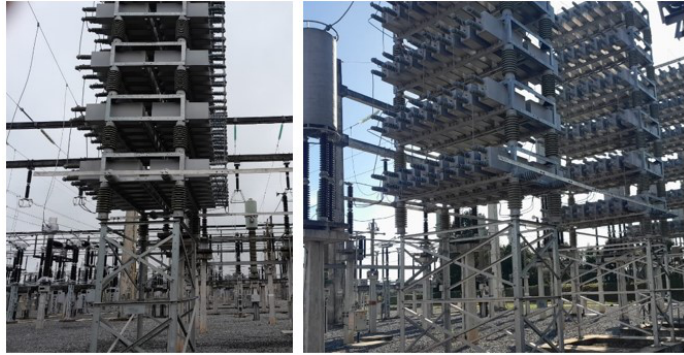
Figure 13. GL 314X circuit breaker, 525/230 kV substation, Copel Geração e Transmissão S.A (Copel Generation and Transmission), Bateias-PR.